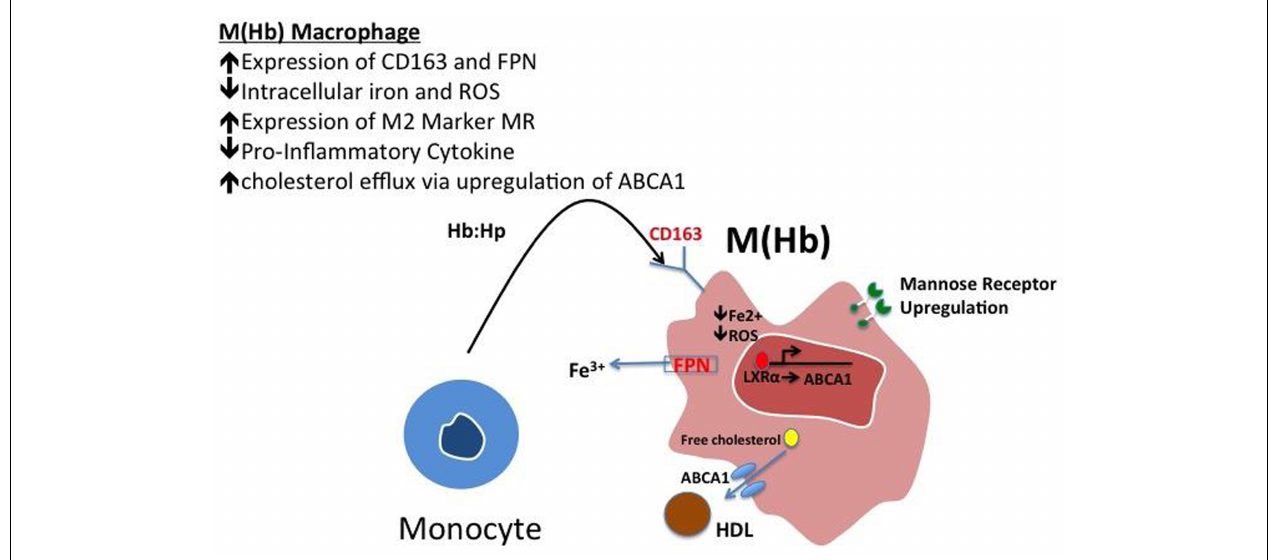
FIGURE 2 | Polarization of hemoglobin-associated macrophage, M(Hb). Macrophage polarization to the M(Hb) phenotype via exposure to hemoglobin: haptoglobin (HH) complex involves the increased expression of CD163, the HH receptor, increased ferroportin-1 (FPN), an iron exporter